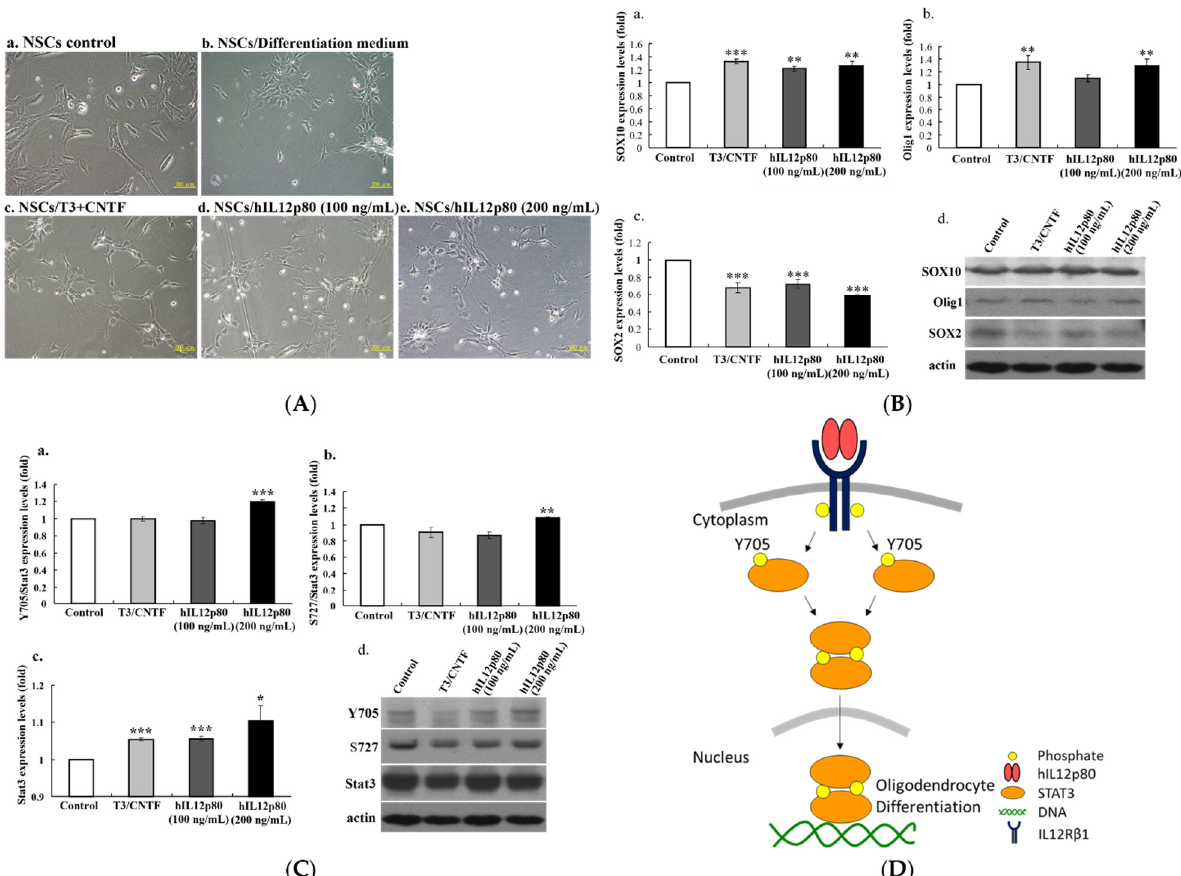
Figure 3. Human IL12p80 stimulated differentiation of mouse NSCs to oligodendrocyte lineages through phosphorylation of Stat3 in vitro. ( A ) The morphology of the differentiated cells from mouse NSCs to oligodendrocytes is due to the addition of T3/CNTF or hIL12p80. ( B ) Quantitative results and a representative profile of immunoblotting with oligodendrocyte markers: ( a ) SOX10, ( b ) Olig1 and a neural stem cell marker: ( c ) SOX2. The Western blot results are shown in Figure ( d ). ( C ) Quantitative results and a representative profile of immunoblotting with the Stat3-Y705 and S727 phosphorylation. ( D ) The illustration of the potential signaling pathway of mouse NSCs differentiated into oligodendrocyte lineages through the hIL12p80-induced phosphorylation of Stat3. Statistical differences compared to the control group are indicated by * p < 0.05, ** p < 0.01, and *** p < 0.001.